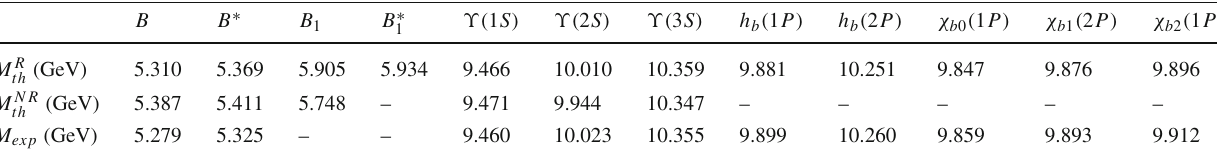
Table 8 Mass spectra of the bottom mesons. M R model [65], and in experiments [75],